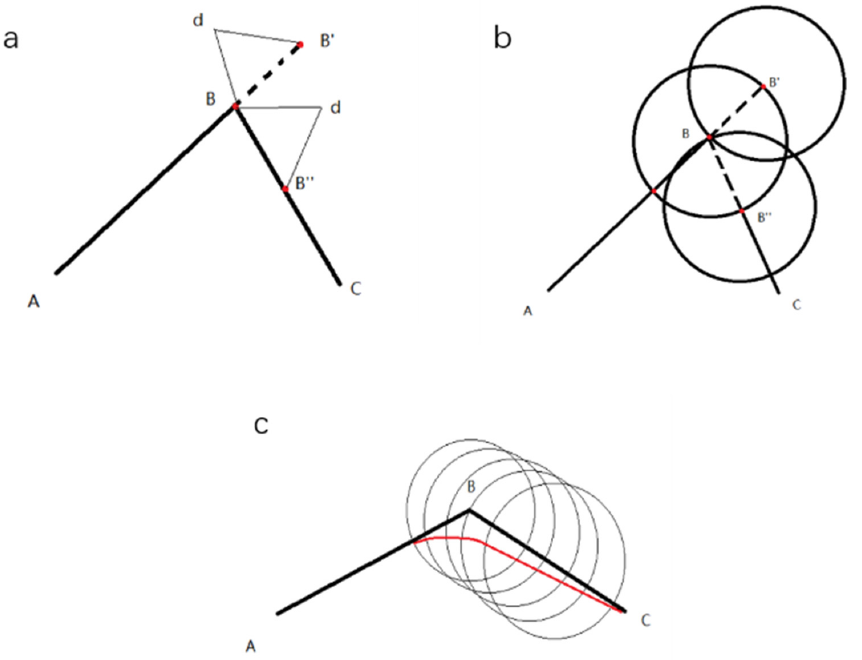
Figure 6. ( a ) Acute angle. ( b ) Optimize the effect of the acute angle. ( c ) Schematic diagram of a general corner fiber track.